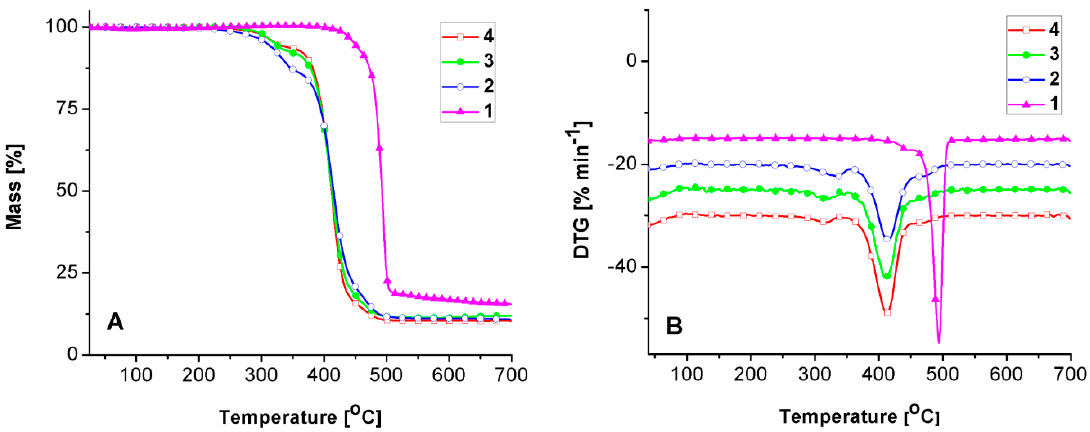
Figure 3. ( A ) TGA and ( B ) DTG curves of the studied samples. Table 1. Data evaluated from DSC measurements.